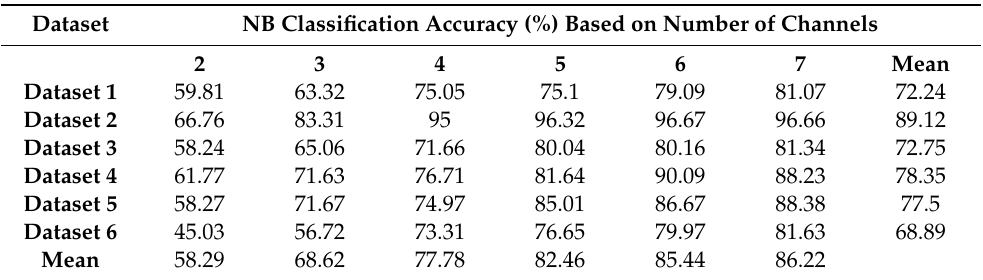
Table 4. Comparison NB classification accuracy for di ff erent datasets based on the number of channels.